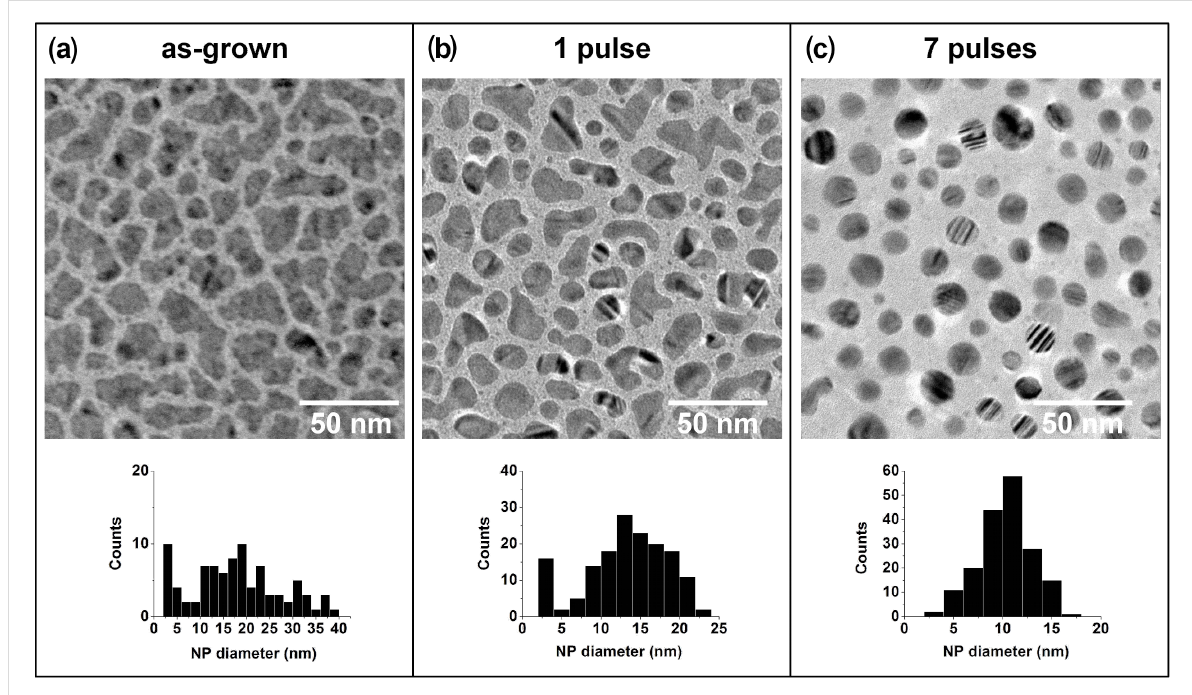
Figure 2: Evolution of the CoPt NPs size and shape as a function of the number of laser pulses. TEM images and the corresponding NPs size disper- sion, (a) before laser irradiation, (b) after 1 laser pulse, (c) after 7 laser pulses.